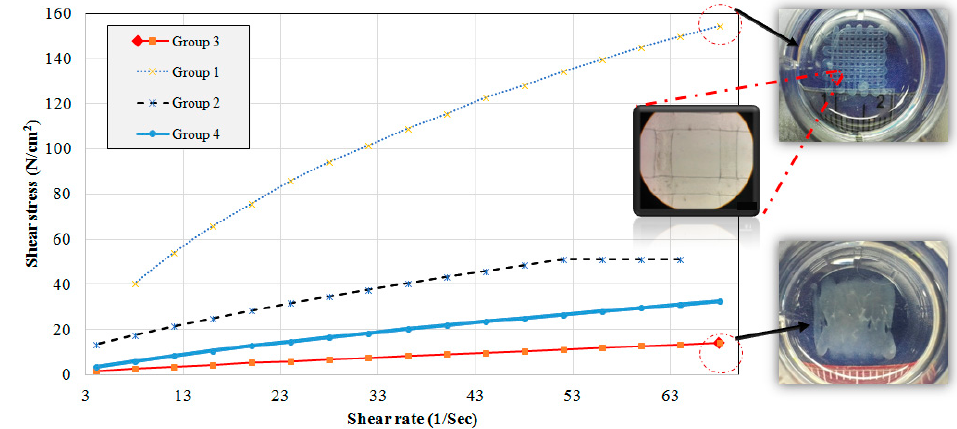
Figure 4. Shear stress as a function of the Shear rate for each solution.